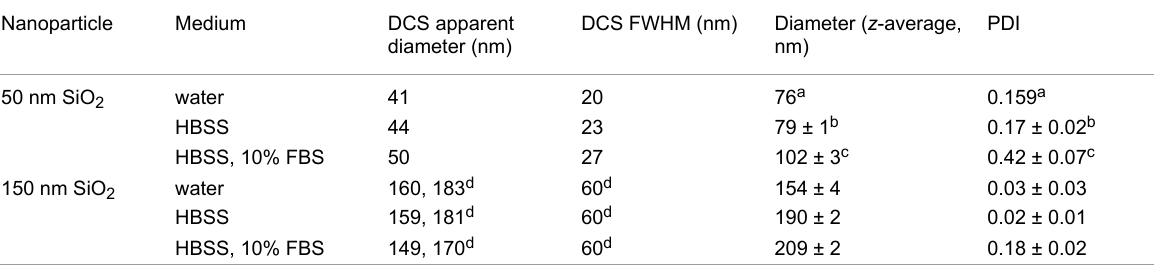
Table 1: Physicochemical characterisation of the 50 nm and 150 nm SiO 2 -NPs in different media. Nanoparticle dispersion (100 µg/mL) in water, serum free HBSS and HBSS supplemented with 10% foetal bovine serum (FBS) were characterised by differential centrifugal sedimentation (DCS) and dynamic light scattering (DLS) as described in the Experimental section. The table shows the apparent diameter and peak full width at half maximum (FWHM) obtained by DCS, together with the results obtained by cumulant analysis of the DLS data ( z -average diameter and polydispersity index, PDI). The corresponding distributions are shown in Supporting Information File 1, Figures S2 and S3. For DLS results, errors represent stan- dard deviation of 4 replicates (11 runs